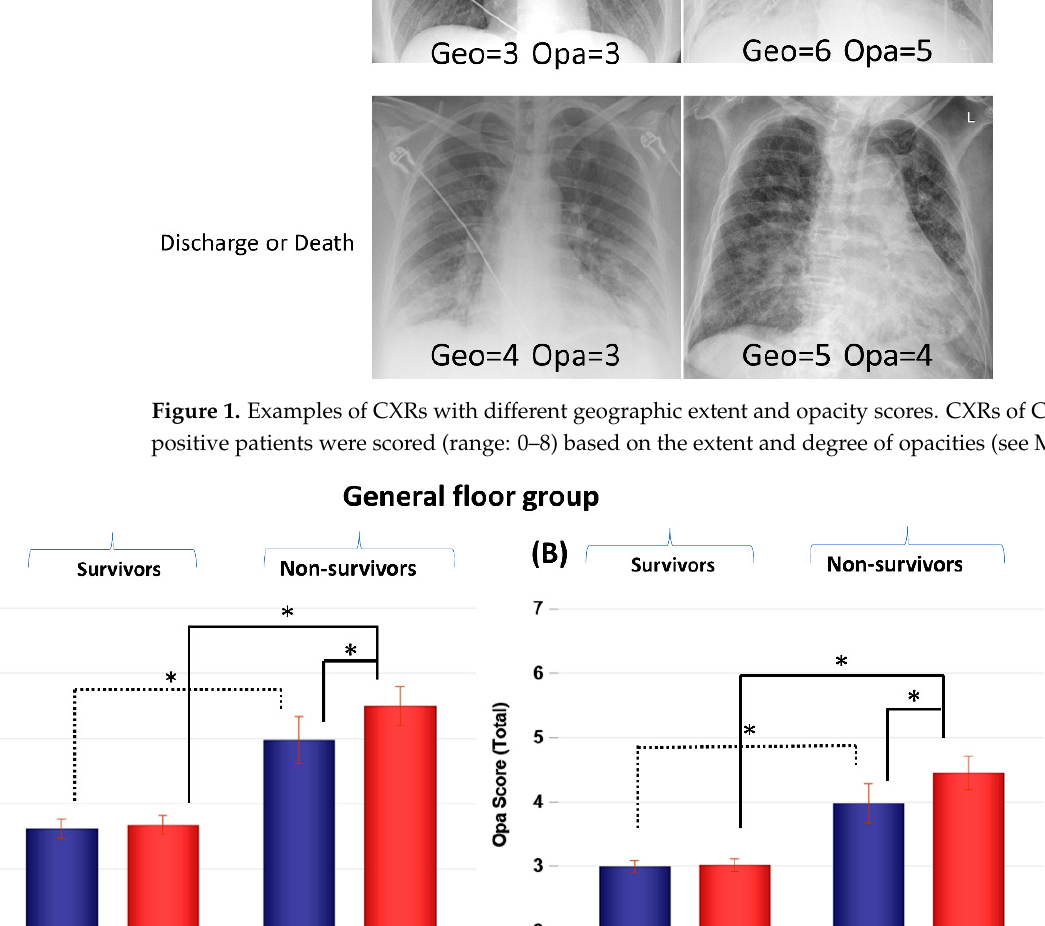
Figure 1. Examples of CXRs with different geographic extent and opacity scores. CXRs of COVID-